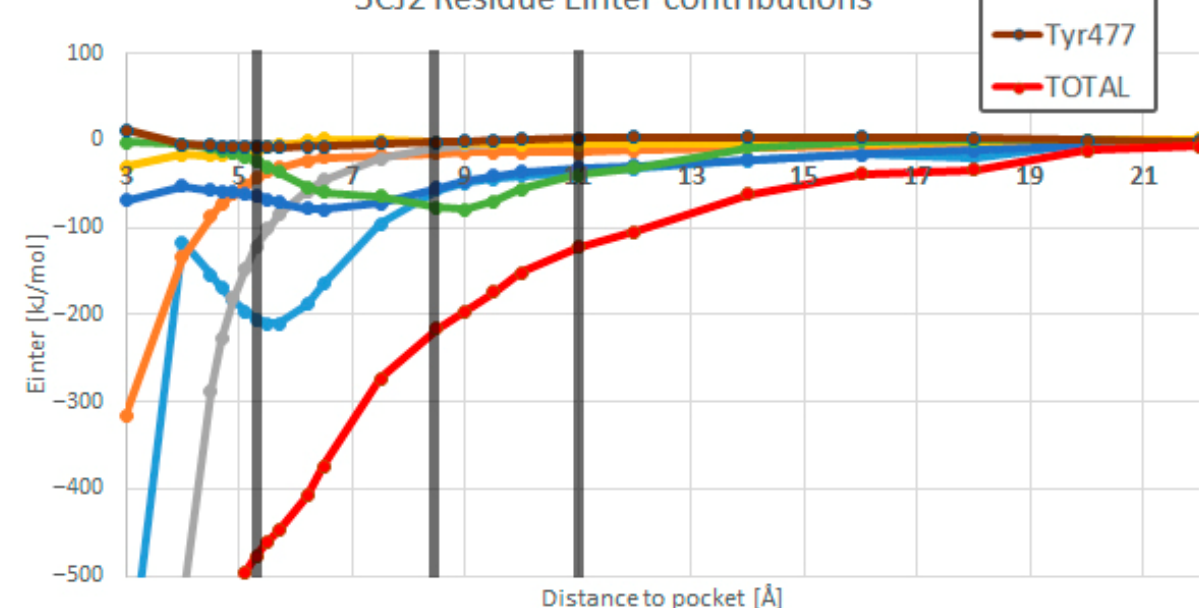
Figure 9. Contributions to ligand–pocket E inter for each of the seven residues in the pocket: (top) 3CJ4 and (bottom) 3CJ2. Vertical black lines represent the separation between the segments studied with the REG method: 2 segments for 3CJ4 and 4 segments for 3CJ2. In segment 1 for both systems, the